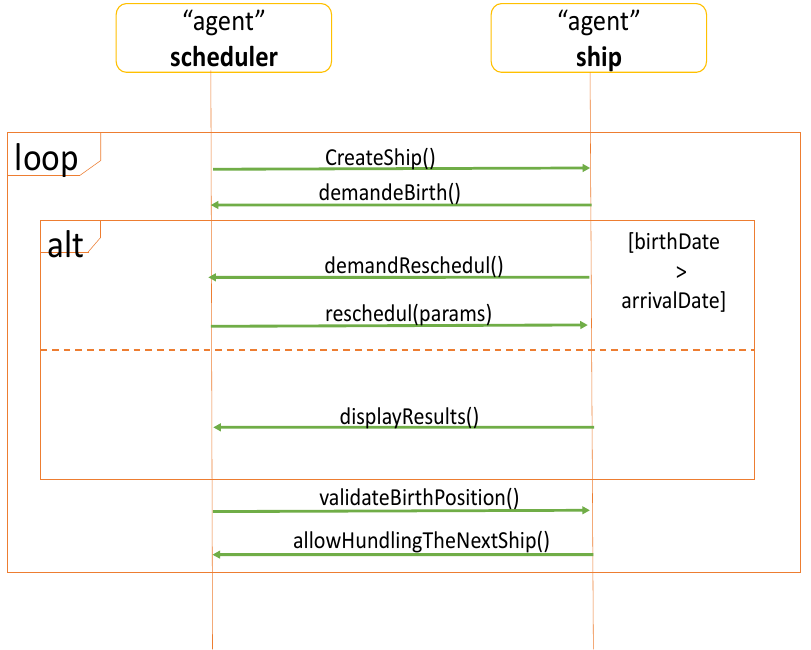
Figure 10. Protocol model between the “scheduling agent” and the “ship agent”.